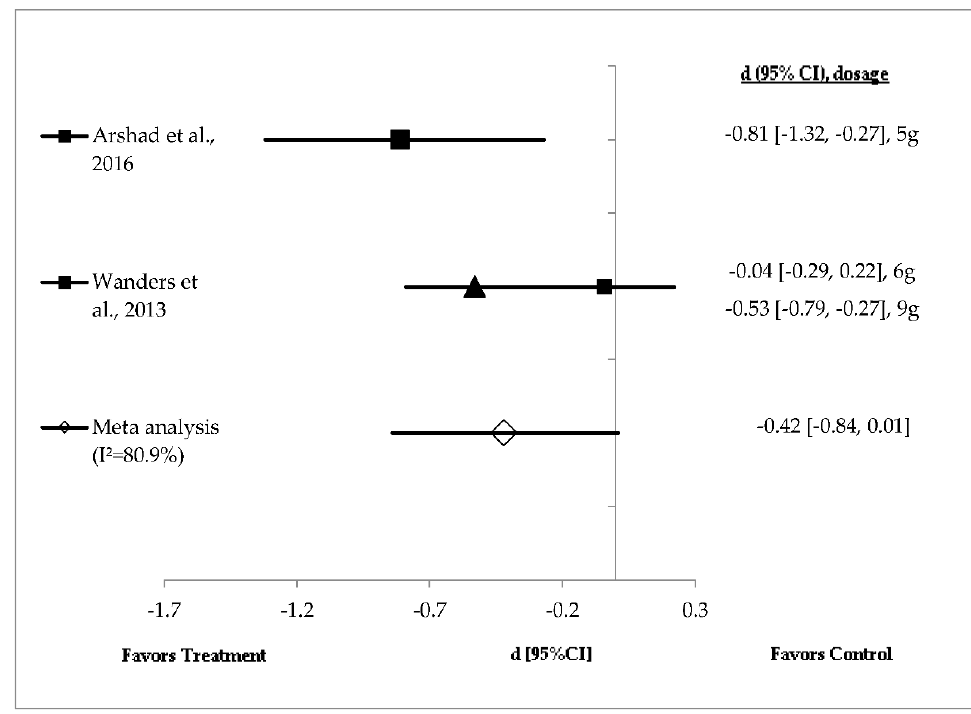
Figure 3. Effects of alginate on energy intake reduction (random effects model). The axis lines on ±0.2, ±0.5 and ±0.8 represent small, medium and large effect sizes, respectively. A negative value of summary effect size suggests that the alginate supplementation decreases energy intake compared with control. ▲ : 9 g alginate; ■ : 6 g alginate.